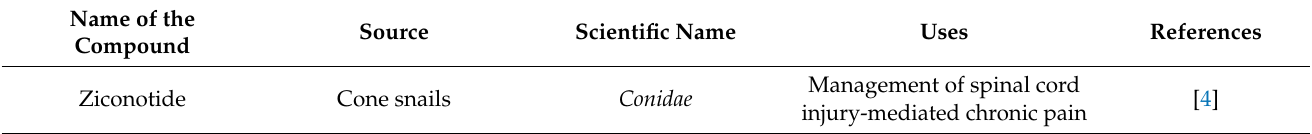
Table 5. The below table lists compounds obtained from marine sources and their uses.